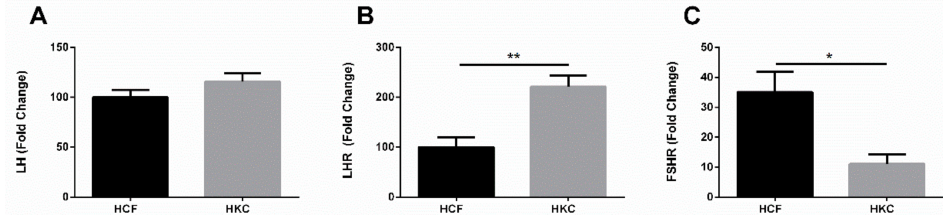
Figure 7. Expression of LH, LHR, and FSHR in HCFs and HKCs. ( A ) LH expression in vitro, ( B ) LHR expression in vitro, and ( C ) FSHR expression in vitro. * p < 0.05, ** p < 0.01. (See Supplementary Materials—Figure